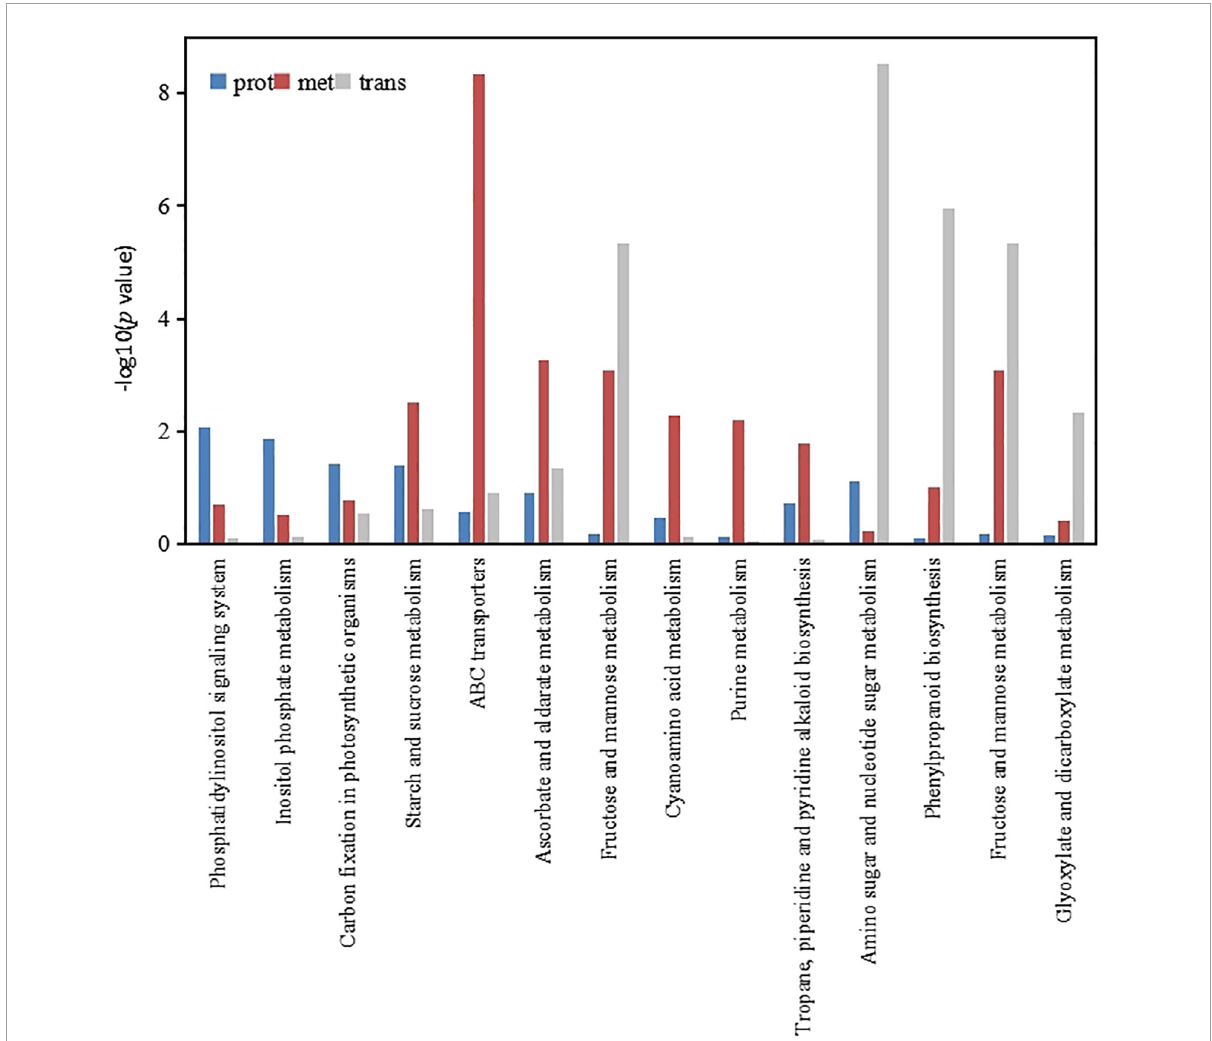
FIGURE6 Histogram of significantly different protein, metabolism and gene KEGG